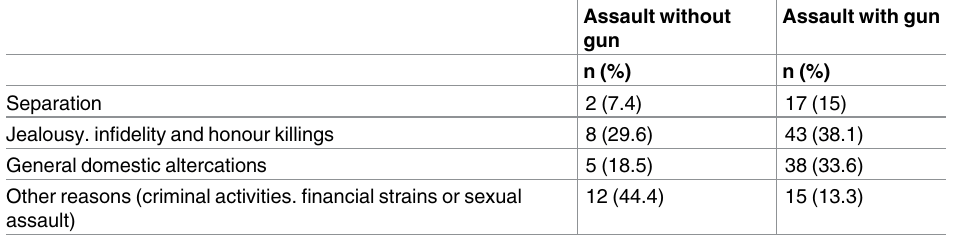
Table 6. Distribution of assault types between the motive